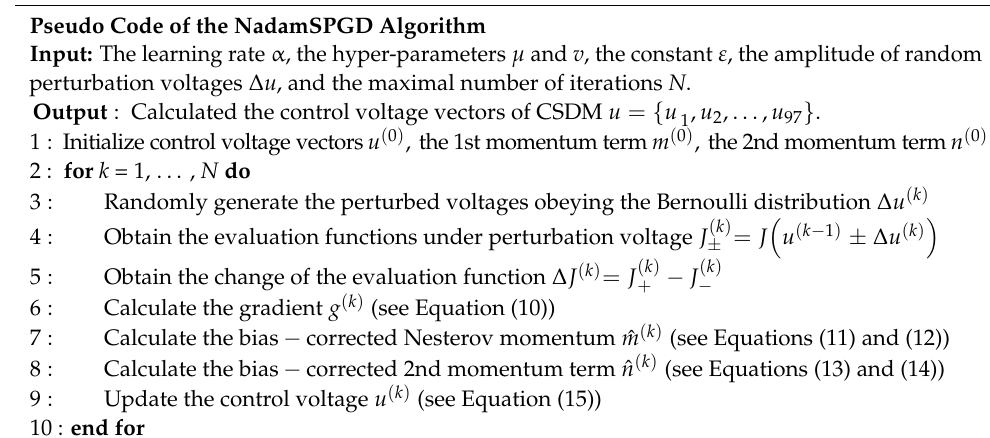
Algorithm 1 Pseudo code of the NadamSPGD algorithm. Pseudo Code of the NadamSPGD